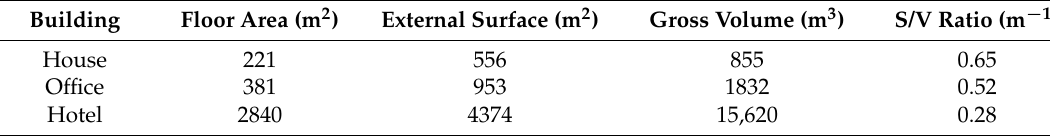
Table 2. Thermal transmittance value of opaque elements of the building envelope for “Good Table 1. Buildings features. (S/V ratio = external Surface area to gross Volume ratio). insulation” and “Poor insulation” buildings.